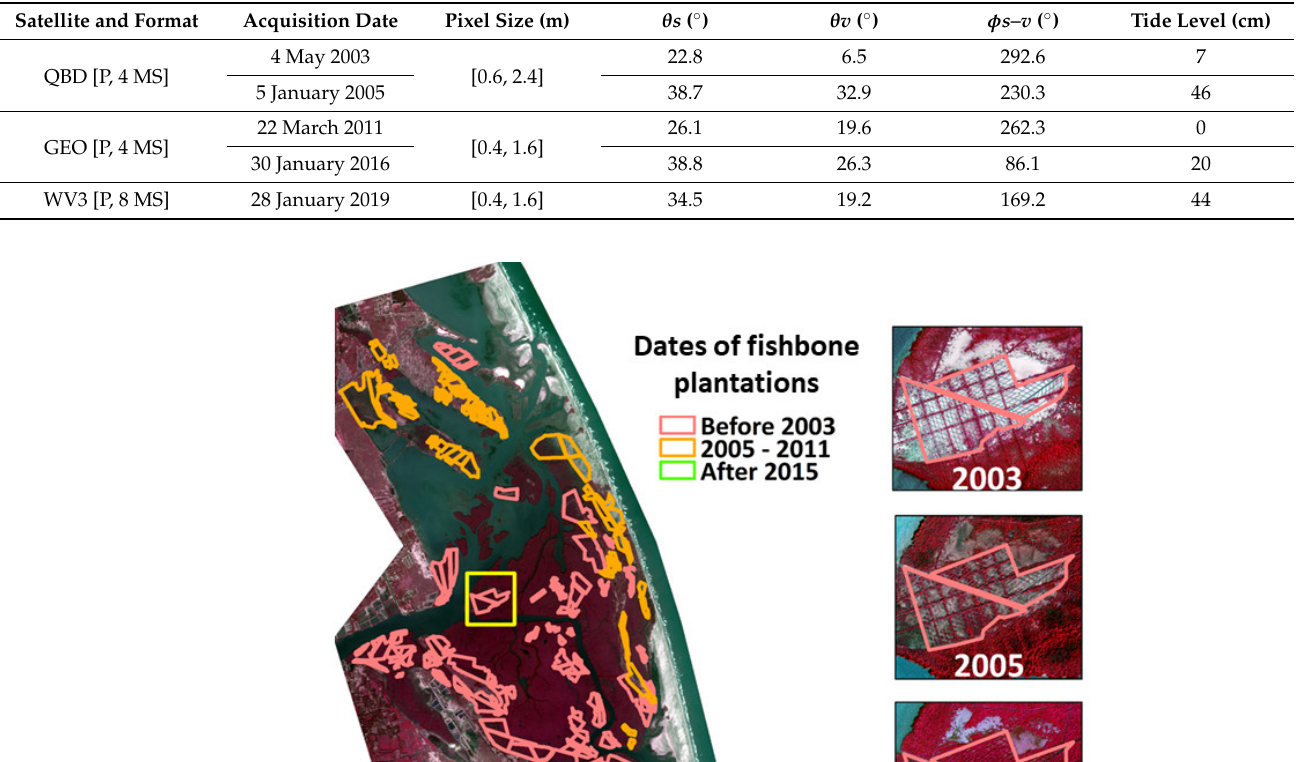
Table 1. Specifications and dates of acquisition of the VHSR images used in this study. The angles θ s and θ v denote the sun zenith and viewing zenith angles, respectively, while φ s–v is the relative sun-viewing azimuth angle. The tide levels during the time of acquisition, obtained from NOAA Tides and Currents (http://tidesandcurrents.noaa.gov, accessed on 12 November 2021) are also indicated. P = panchromatic; MS = multi-spectral.